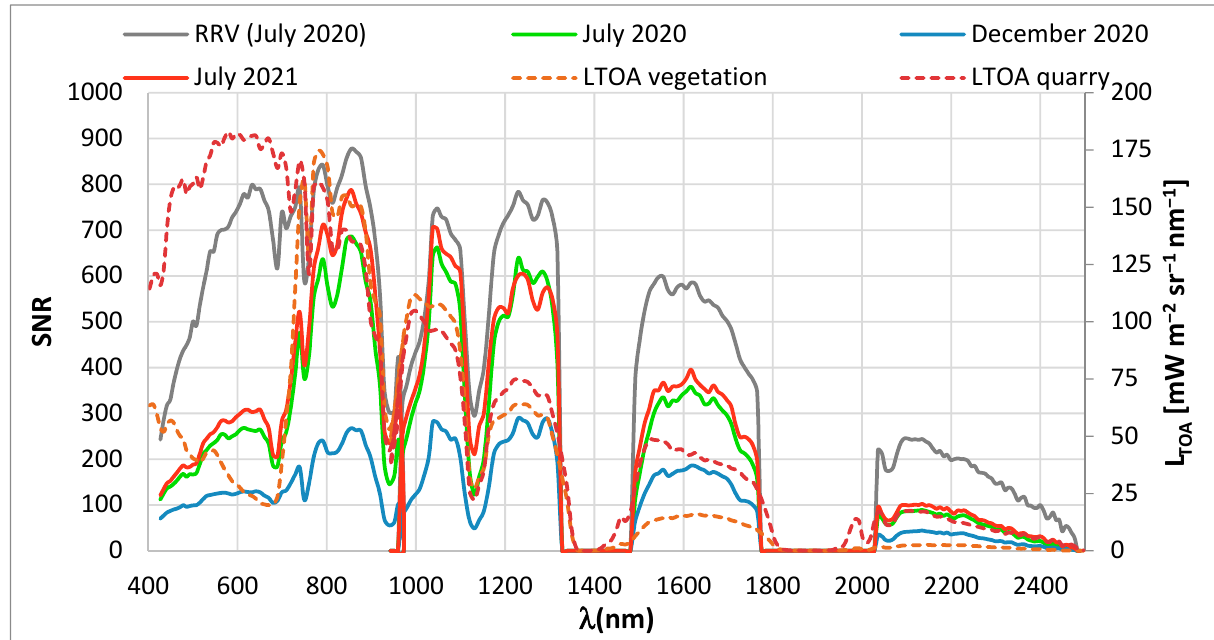
Figure 7. SNR of the LTOA of three Pignola PRISMA images and, as reference, the RRV radiance spectra together with the LTOA for green vegetation and limestone quarry.